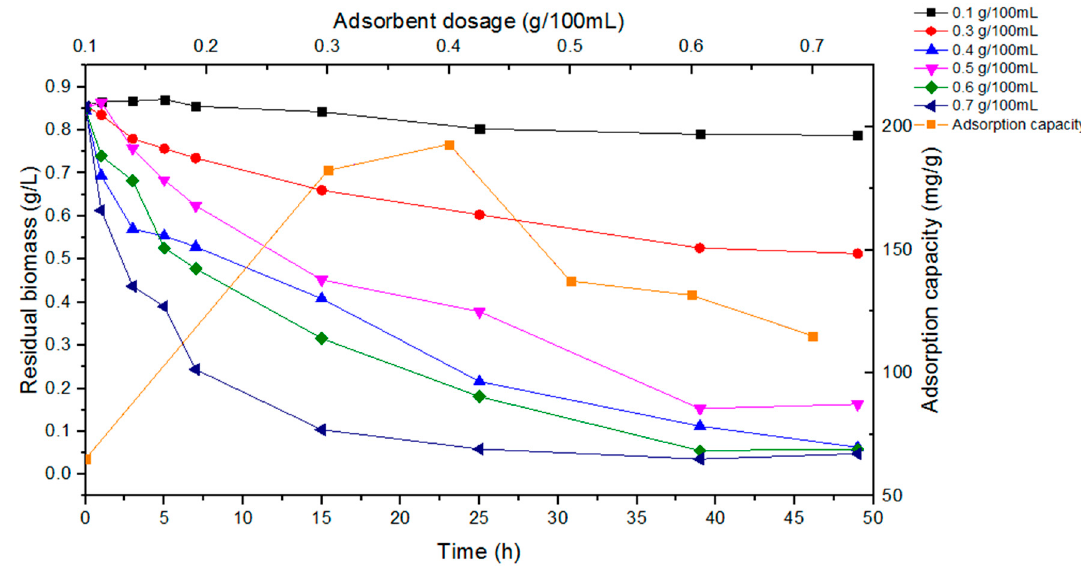
Figure 4. The time courses of residual biomass concentrations of microalgae adsorbed onto various dosages of acid-modified sugarcane-bagasse-based adsorbent and the consequent adsorption capacities from the use of each adsorbent dosage.